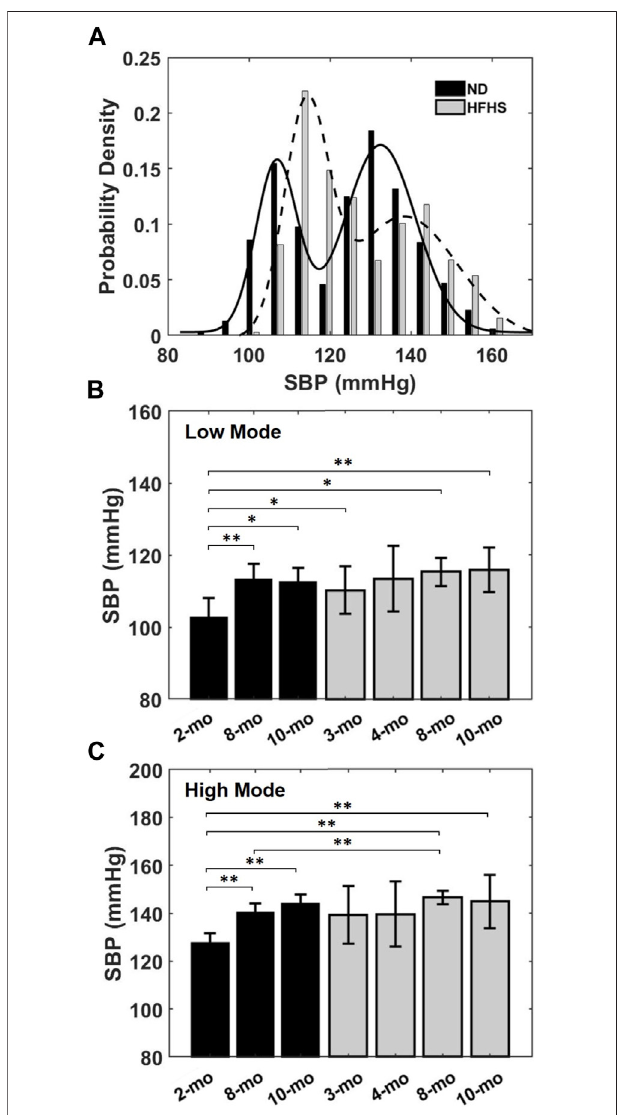
FIGURE3|(A) Representativebimodalprobabilitydensitydistributionof SBP over a 24-h period for a 2-months ND and a 3-months HFHS mouse. Solid and dashed lines are Gaussian distributions fi t to the data. The low and high pressure values of the bimodal SBP distribution for each age and diet groupswere averaged and showed in (B,C) forthe lowand highpressure means, respectively, for the age and diet groups (* p < 0.05; ** p <